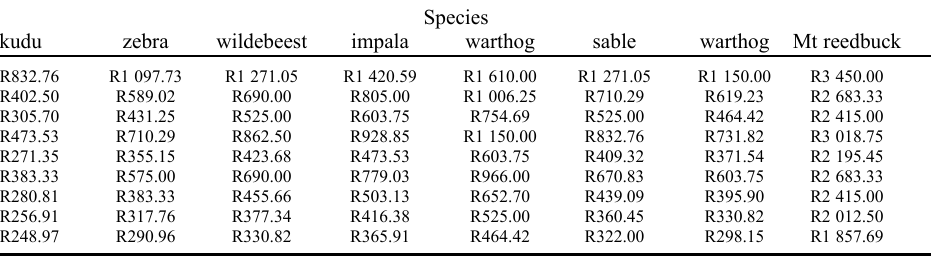
Table 4 Cost per percent statistical power (1-beta) to show 15% population change at 10% significance for populations (stock) on Loskop Dam Nature Reserve (power analysis based on actual counted replicates) using helicopter based surveys at current